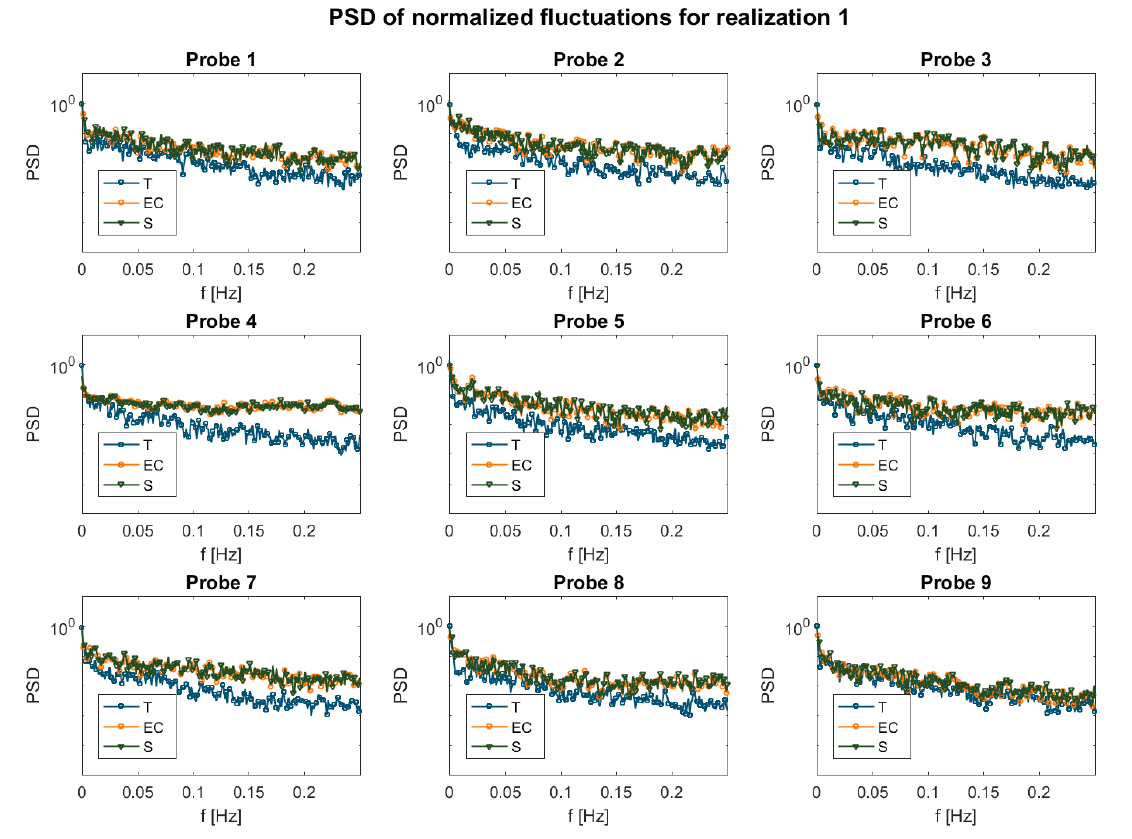
Figure 22. Power spectral density (PSD) of normalized fluctuations for temperature (T), electrical conductivity (EC), and salinity (S) in Realization